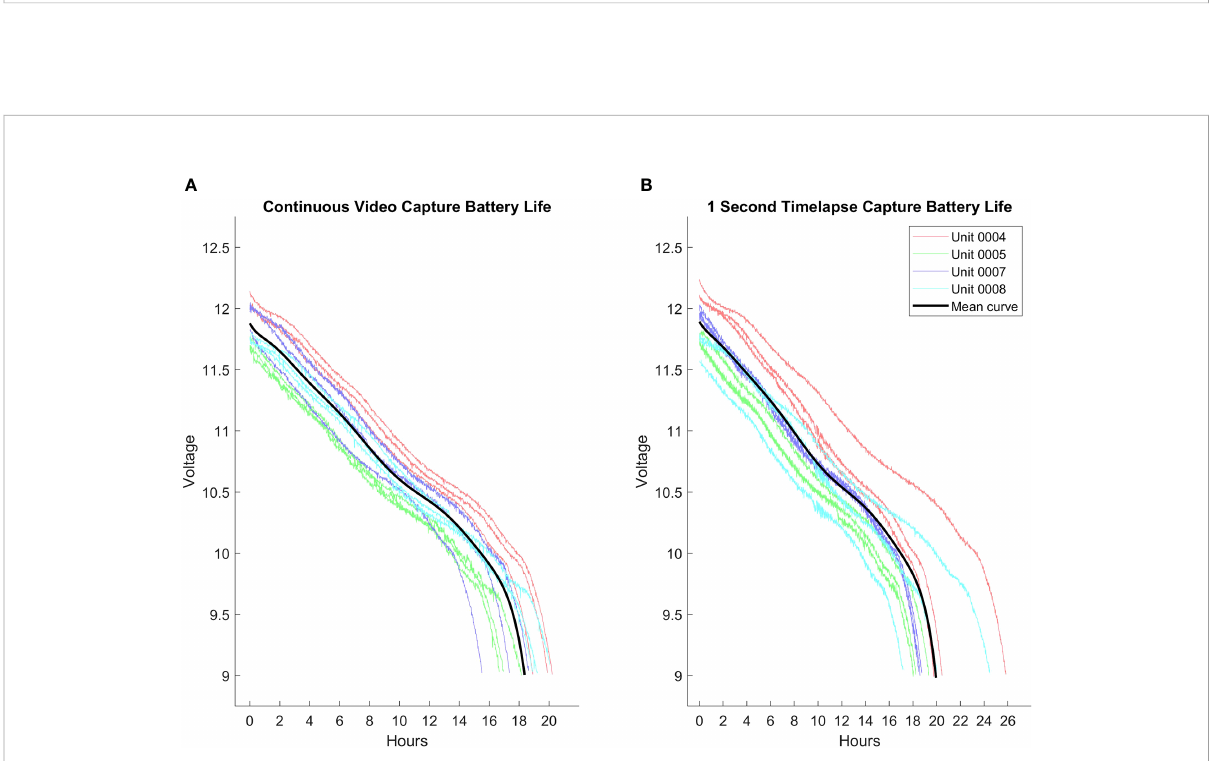
FIGURE 12 (A) Pro fi le of the Maka Niu battery voltage for continuous video recording. Standard deviation for runtime duration is 1.5 hours. (B) Pro fi le of the Maka Niu battery voltage for time-lapse imaging at 1-second intervals. Standard deviation for runtime duration is 2.6 hours. Note that the current design of the charging hardware terminates charging when current drops below a certain threshold. Since the cutoff is not based on voltage obtained, the units have inconsistent starting charge, which leads to considerable standard of deviation in the runtime duration. The mean curve in each graph was generated as a 10-degree polynomial estimation of the battery runs stretched or compressed to the average runtime of each set.